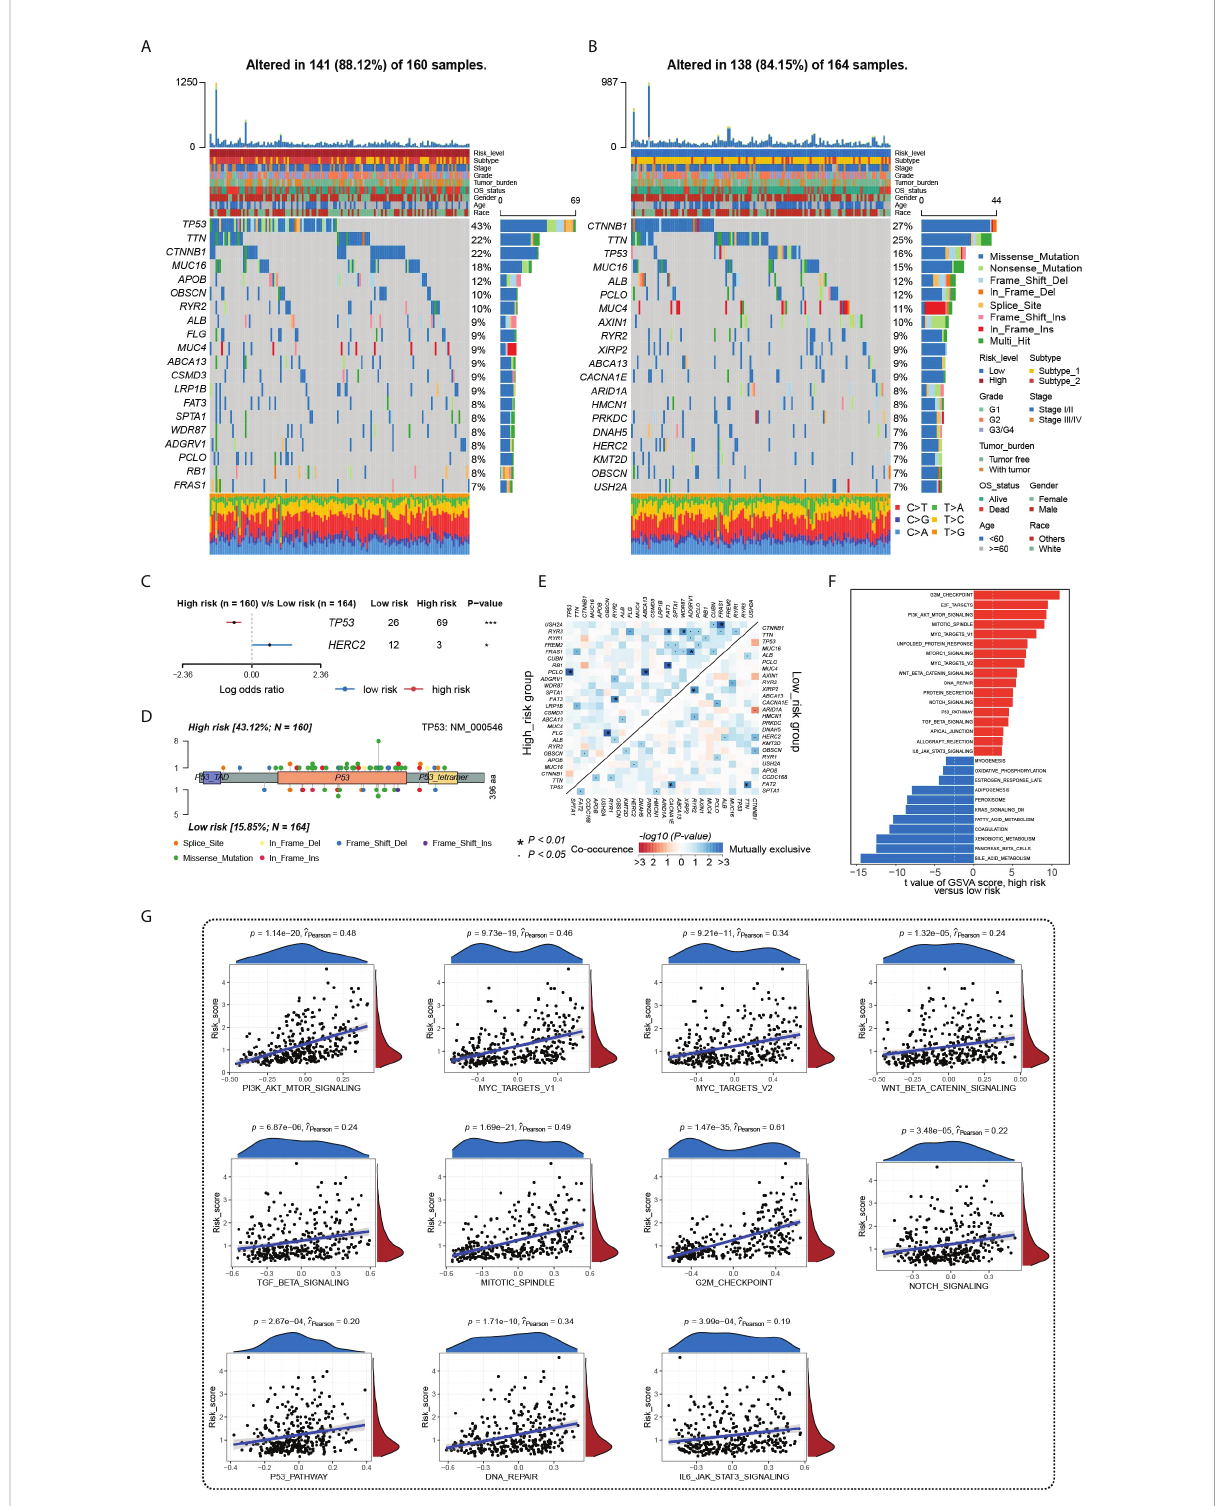
FIGURE 6 Underlying molecular mechanisms of HGSIS. (A, B) Oncoprint analysis of the high-risk (A) and low-risk groups (B) . (C) Forest plot showing genes mutated differentially in patients of the low- and high-risk groups. (D) Lollipop plot of mutation sites of TP53. (E) Interaction effect of 25 mutated genes in the low- and high-risk groups. (F) Distinct hallmark pathways between the two HGSIS risk groups. (G) Correlation analysis between 11 oncogenic hallmark pathways and HGSIS-based risk score, respectively. * means p < 0.05; *** means p <